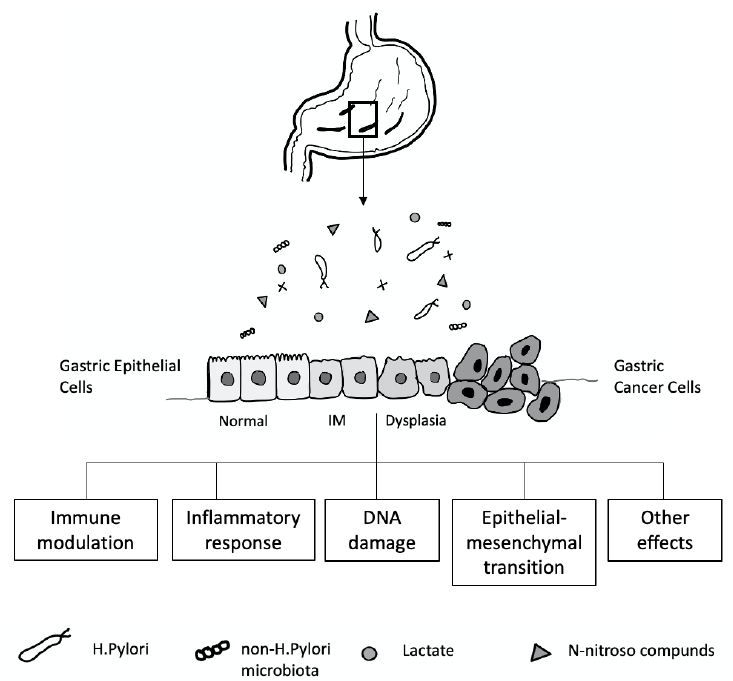
Figure 4. Gastric microbiota and the development of gastric cancer cell relationship.